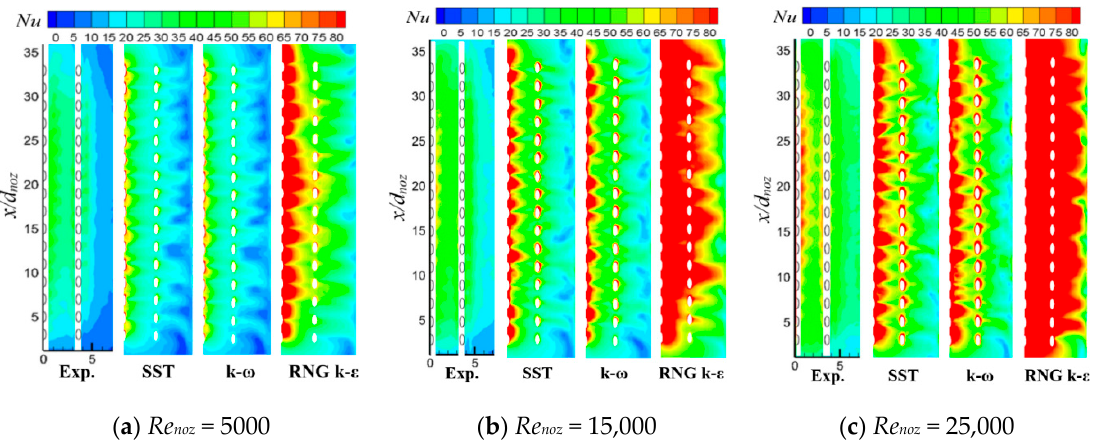
Figure 3. Nusselt number contours for both experimental (without mainstream [39]) and numerical results of swirl cooling at ( a ) Re noz = 5000, ( b ) Re noz = 15,000 and ( c ) Re noz = 25,000.